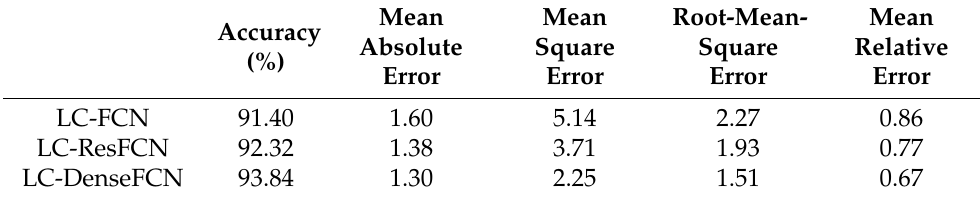
Figure 3. The point supervision algorithm training progress through 100 epochs (MAE means Mean Absolute Error). Table 1. Accuracy and error values of three point supervision methods.